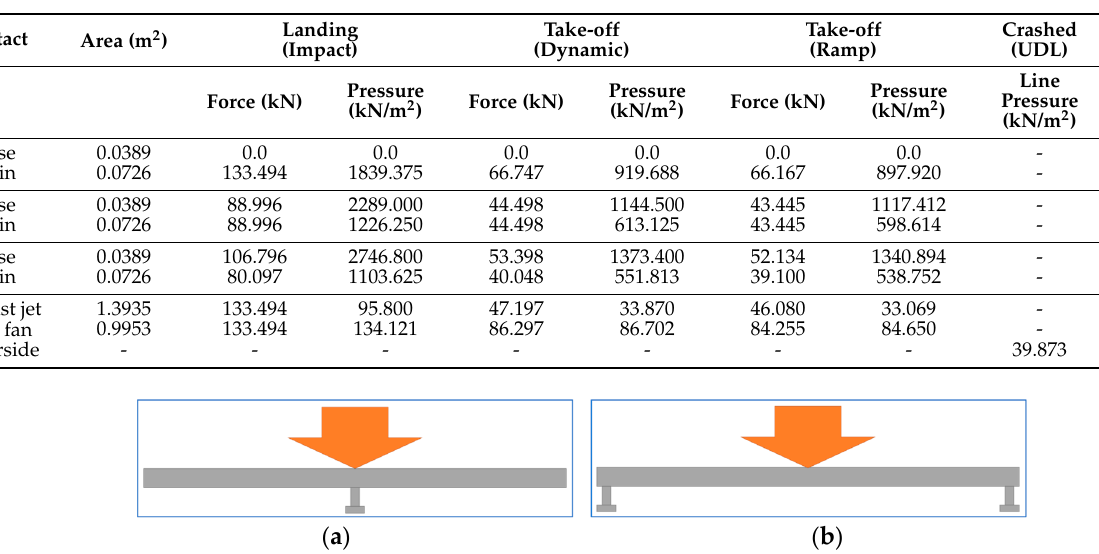
Figure 6. UDL loading scenarios for deck plate with ( a ) one stiffener and ( b ) two